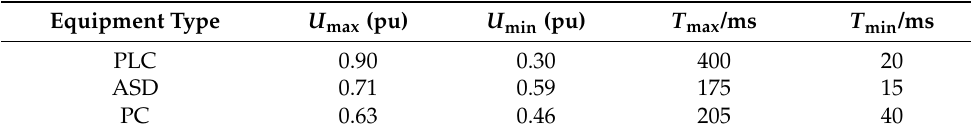
Table 3. Sensitive equipment’s voltage and duration limits.